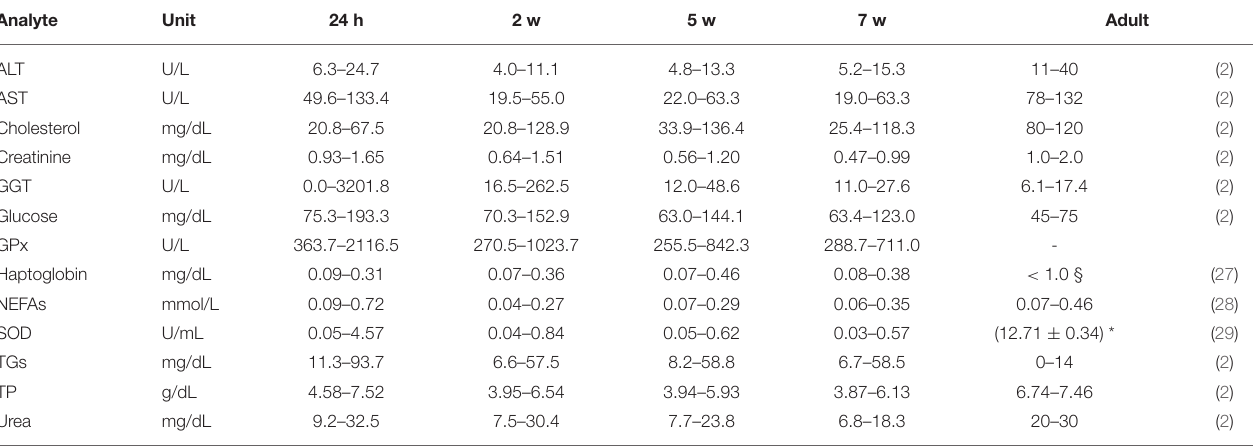
TABLE 3 | Reference intervals (RIs) of clinical biochemistry analytes from calves of 24h of age (24h after colostrum taking) 2, 5, and 7 weeks of age and RIs of adult cattle from literature. Analyte